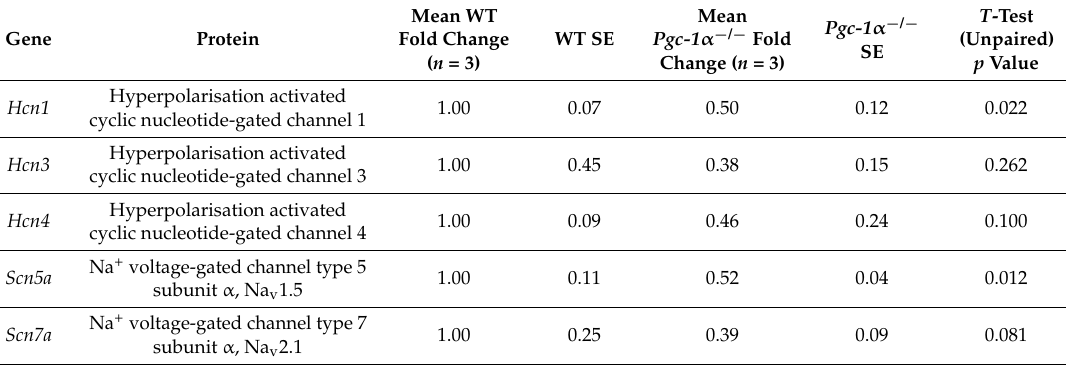
Table 3. The mean gene fold changes underlying channels relating to the initiation of excitable activity in Pgc-1 α − / − compared to WT